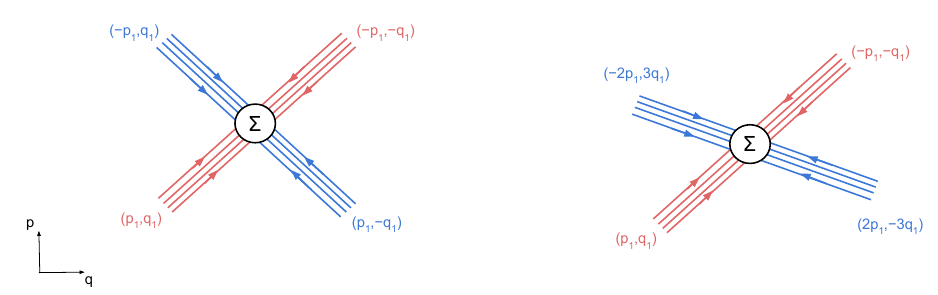
Figure 5 . A schematic picture of two known classes of four-external brane backgrounds allowing supersymmetric, minimal energy F1-string embeddings; (a) has p 2 = p 1 and q 2 = q 1 , while (b) has p 2 = 2 p 1 and q 2 = 3 q 1 . Charges p 2 = (cid:0) 2 p 1 and q 2 = 3 q 1 are also allowed, though not